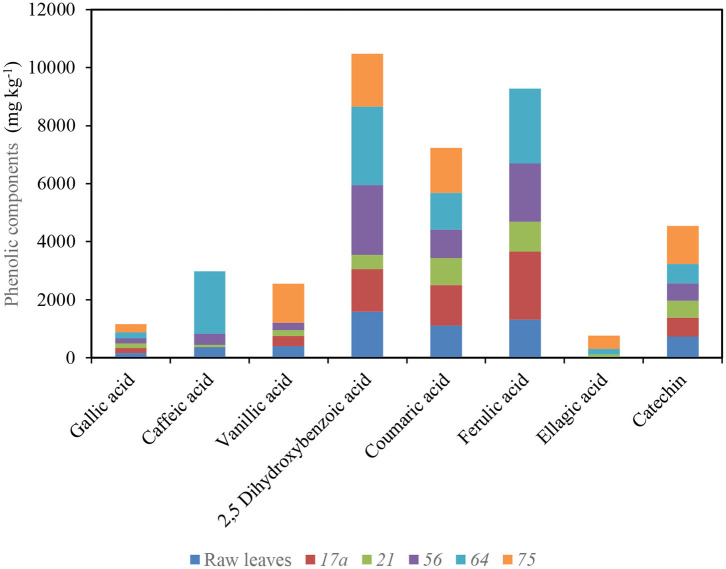
Impact of fermentation with different lactic acid bacterium strains on different phenolic components in African nightshade (S. retroflexum) leaves (75 L. plantarum, 21 and 64 Weissella cibaria, and 56 Leuconostoc pseudomesenteroides). Source (53).